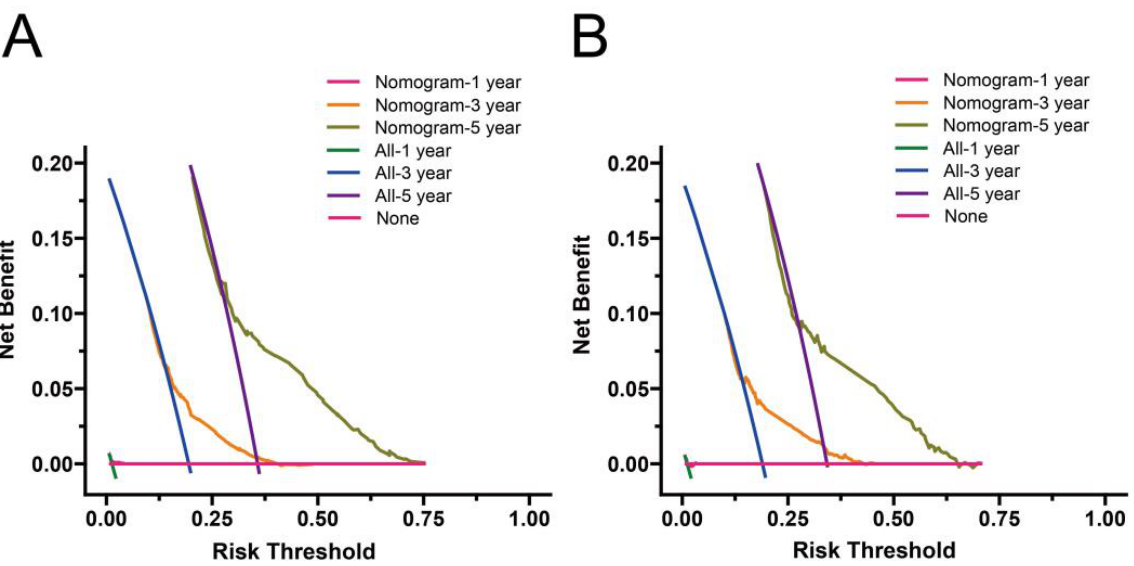
Figure 5. Calibration curves of the nomogram for predicting overall survival: ( A ) at 1 year in the training cohort; ( B ) at 3 years in the training cohort; ( C ) at 5 years in the training cohort; ( D ) at 1 year in the validation cohort; ( E ) at 3 years in the validation cohort; ( F ) at 5 years in the validation cohort. OS: overall survival.